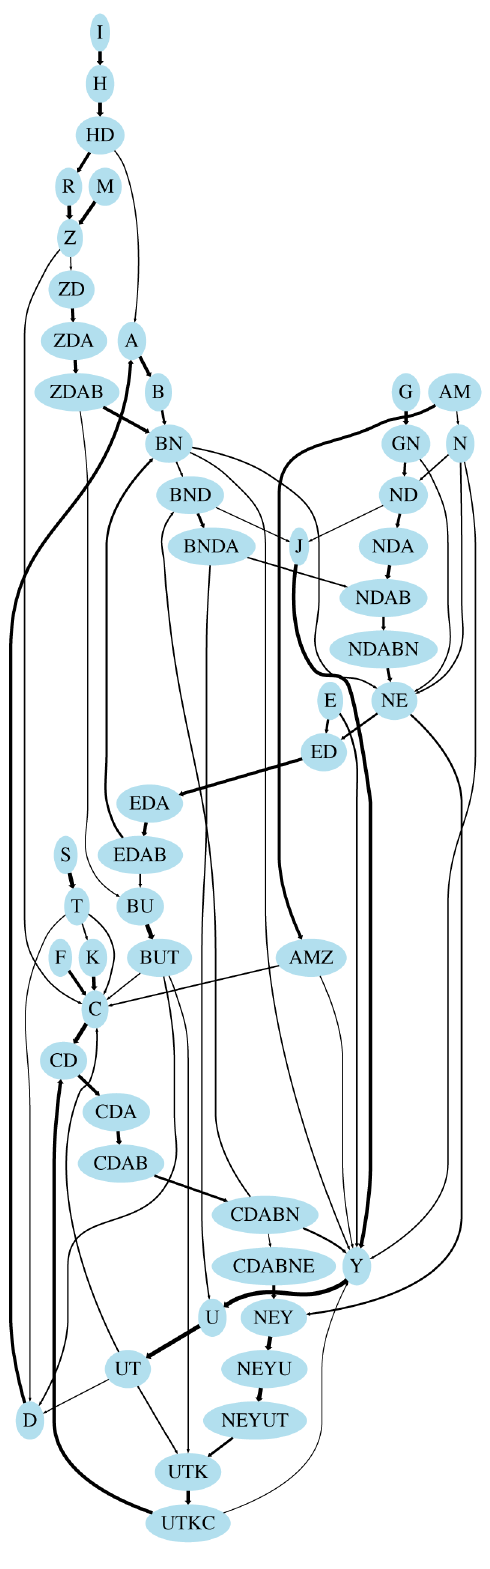
Figure 8. Probabilistic finite automata (PFA) computed from prediction suffix trees (PSTs) reveal the complexity of canary song. The PFA shown here corresponds to the PST from the top of Fig. 5 . Edges represent transitions between states, and the width indicates the probability of a given transition. Transitions from one